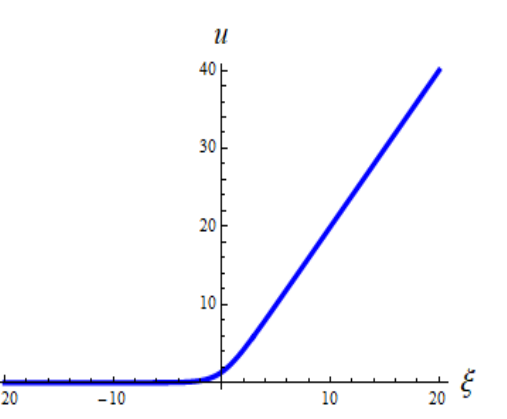
Figure 2: (a) 2D plot for u 3 . (b) 3D plot for u 3 ( x , y ) , when t = 0